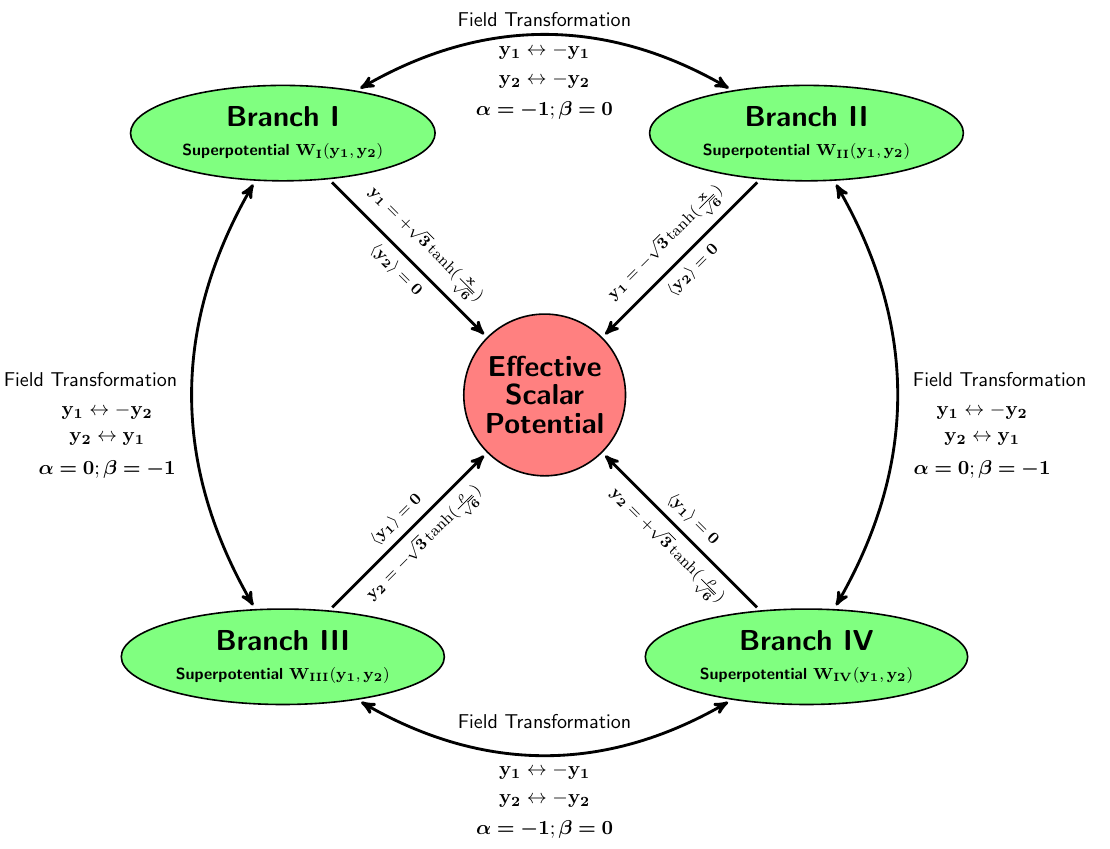
Figure 2 . This diagram shows the transformation laws between the superpotentials in di(cid:11)er- ent branches, together with the (cid:12)eld (cid:12)xings and canonical (cid:12)eld rede(cid:12)nitions that yield the same Starobinsky-like e(cid:11)ective scalar